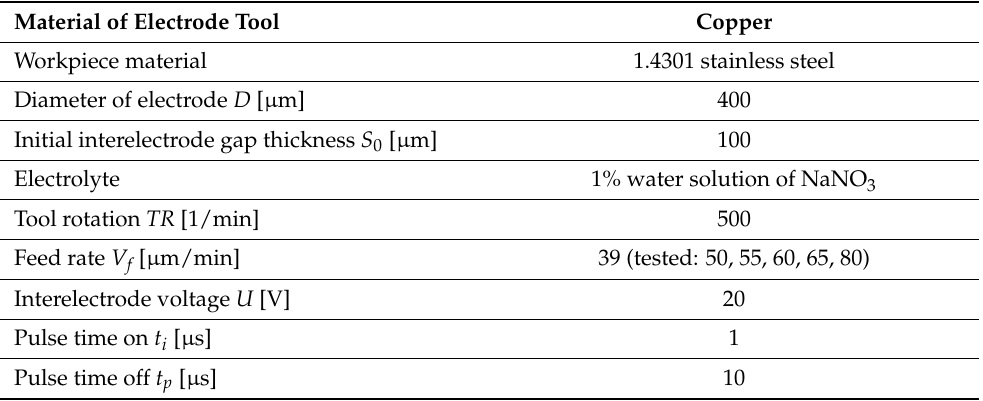
Figure 19. Scheme of the rotary ECM process with: ( a ) co-rotating electrolyte supply; ( b ) top and side view of the cavity with nominal dimensions [33]. Table 4. Input and constant machining parameters for rotary ECMM tests [33].